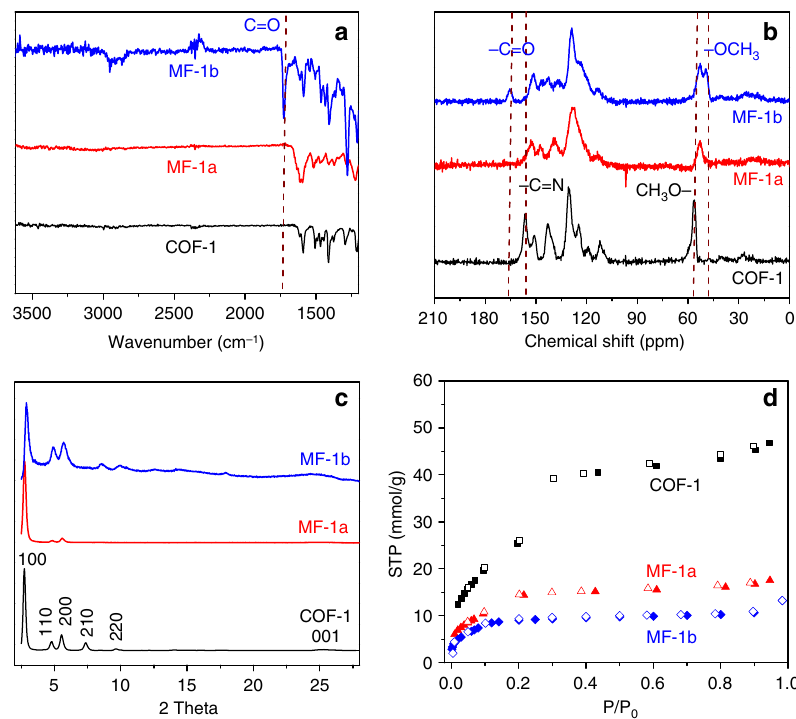
Fig. 2 Characterization of original COF-1 (black) and post-synthetically modi fi ed MF-1a (red) and MF-1b(blue). a FT-IR spectra. b Solid-state 13 C CP-MAS NMR spectra. c PXRD patterns showing retention of crystallinity after the Povarov reaction. d N 2 sorption isotherm